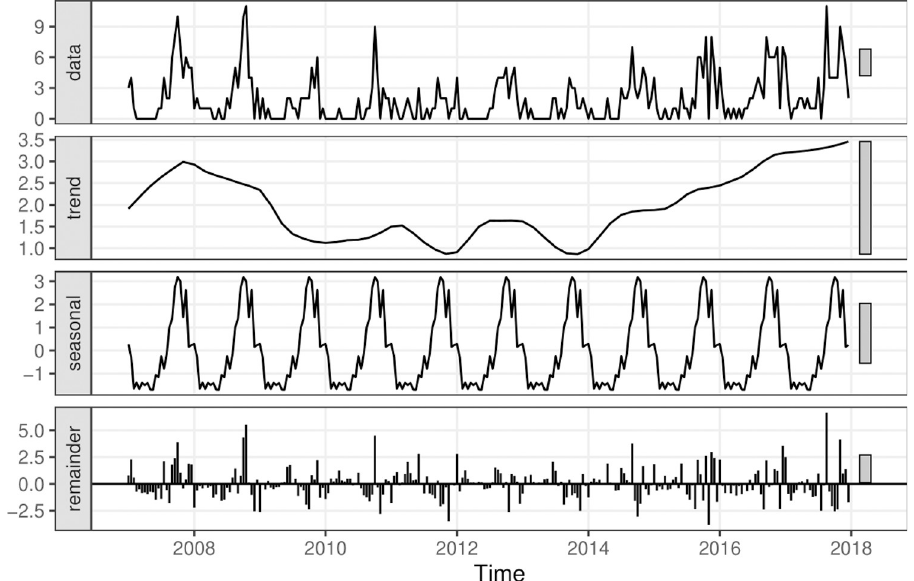
Fig 2. Seasonal-trend decomposition based on Loess smoothing of paralysis tick admissions. The raw time series (shown in the data panel at the top) was decomposed into trend, seasonality and remainder components. Our unit of analysis for two prediction models (ARIMA seasadj and GARCH seasadj ) was the seasonally adjusted series, taken as the sum of the trend and remainder. Remaining models used either the raw count data (GAM raw ) or a log(x+1) transformation of the raw data as the outcome (Prophet raw , and ETS raw ). Bars in panels represent relative differences in y-axis scales.